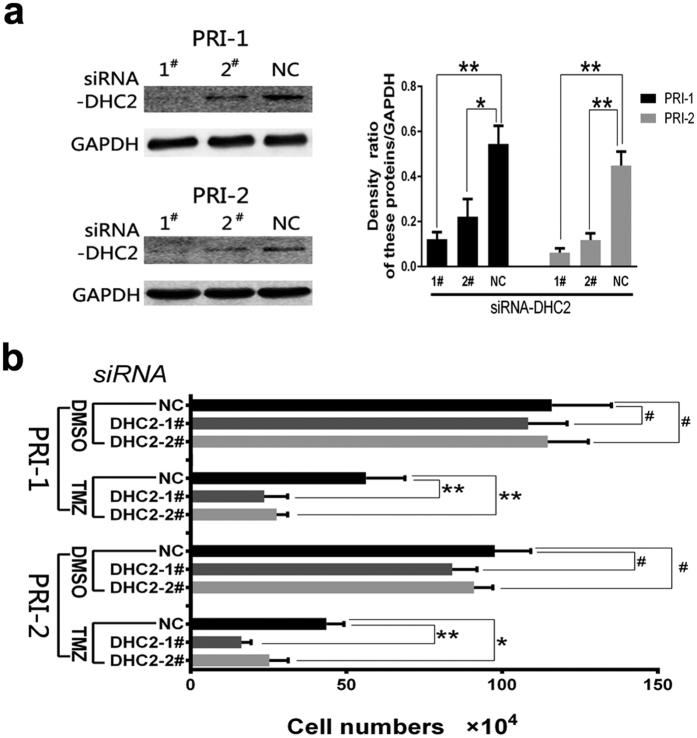
Knockdown of DHC2 expression in 2 different primary GBM cell lines.(a) Western blot. Cells were grown and transfected with two different siRNAs for 8 h and cultured for 48 h and then subjected to Western blot analysis of protein expressions. The graph is the summarized data of the blot. *P < 0.05; **P < 0.01. (b) Changes in viability of cells after knockdown of DHC2 expression followed by temozolomide treatment for one week. Cells were then counted and the graph showed the number of survival cells in different groups (#P > 0.05; *P < 0.05; and **P < 0.01).